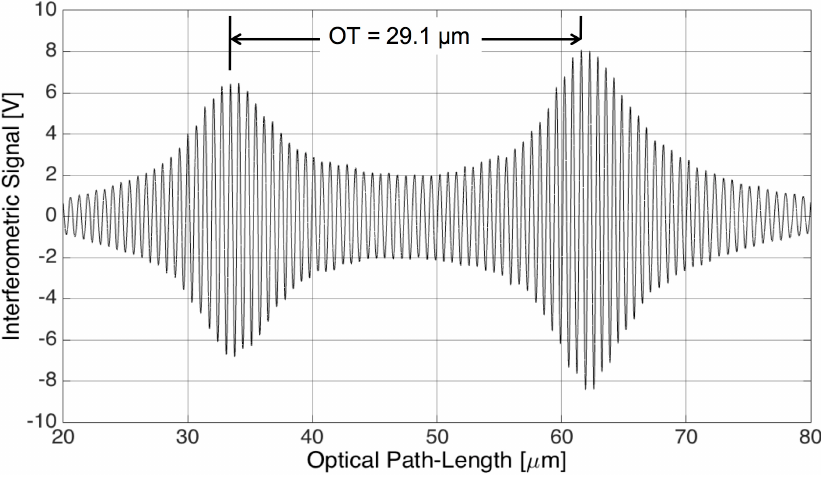
Figure 2. Interferometric signal as a function of optical path-length variation of the reference arm.